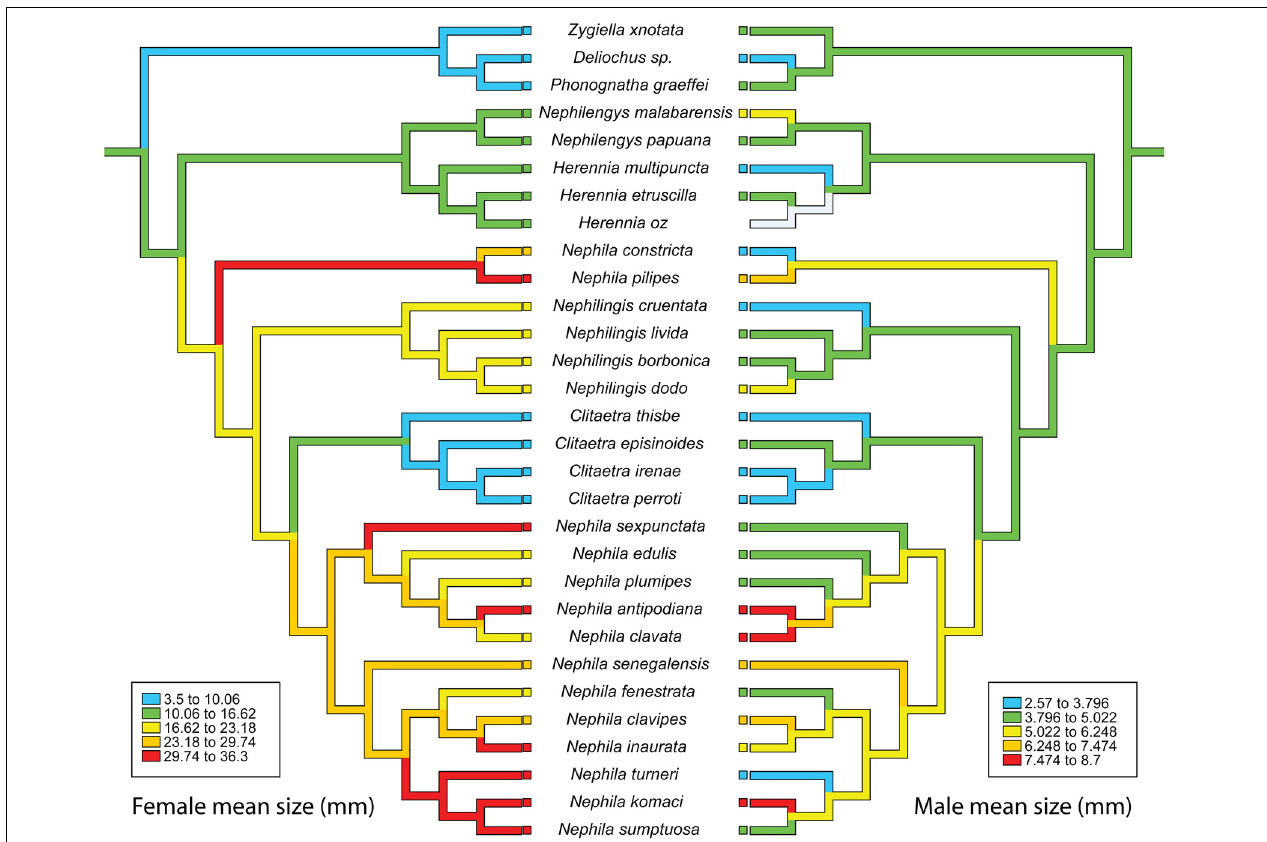
FIGURE 2 | Reconstructed evolution of female (left) and male (right) mean sizes in nephilid spiders. The lack of correlation implies that sexual size dimorphism evolves as a response of different selection pressures on females and males.